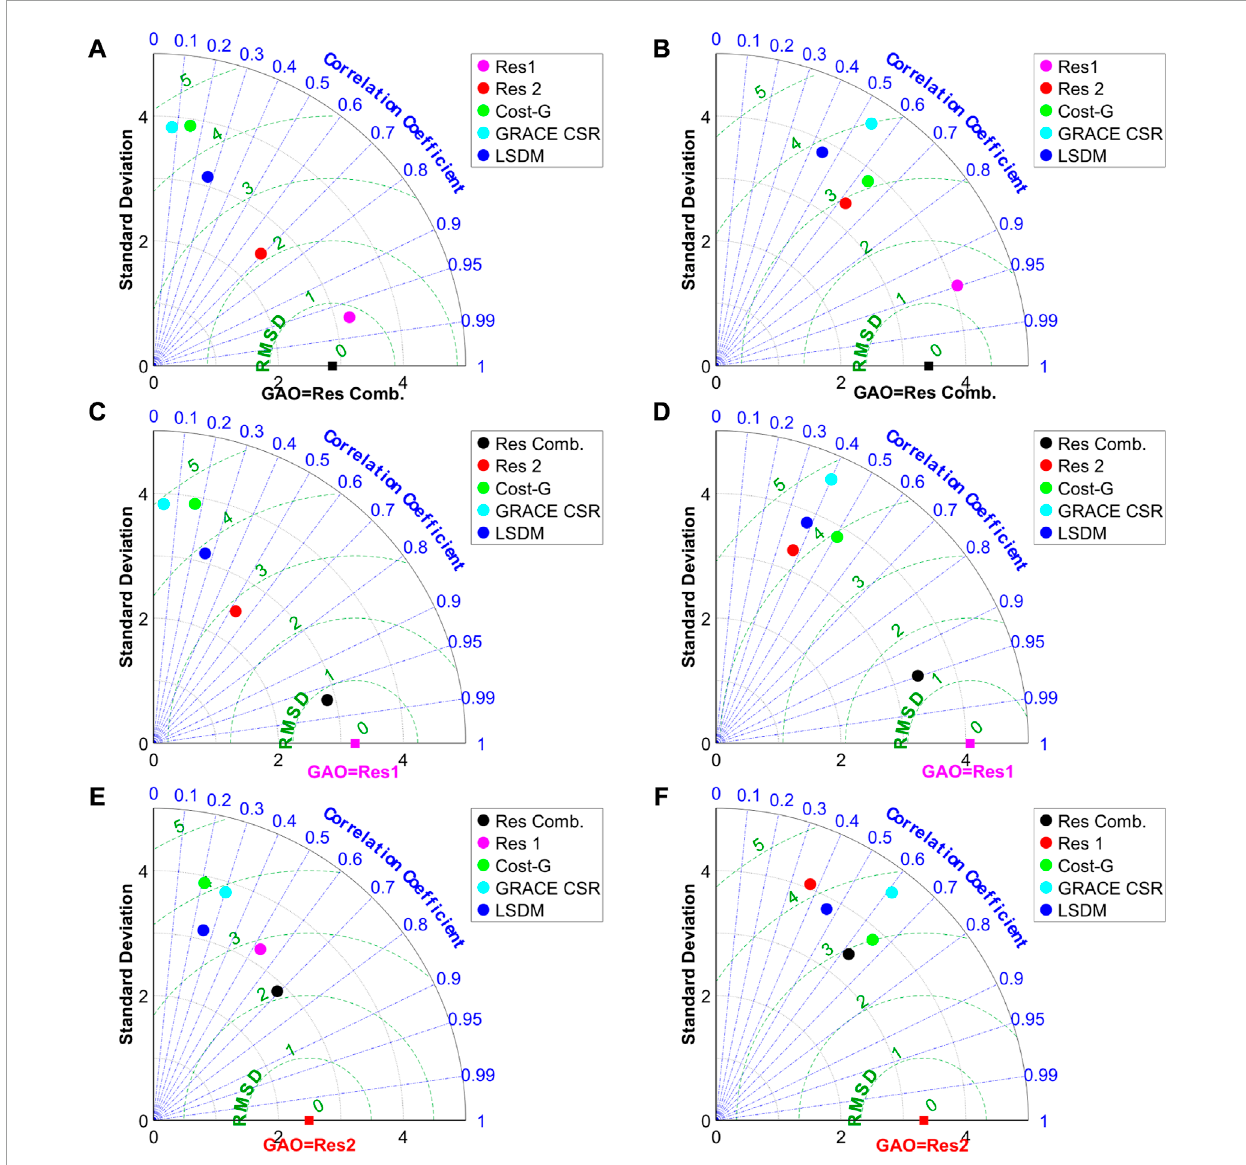
FIGURE 10 Taylor diagrams showing a comparison of χ 1 and χ 2 non-seasonal components of three different geodetic residuals as a reference vlaues: (A) χ 1 of Res Comb. (B) χ 2 of Res Comb., (C) χ 1 of Res1, (D) χ 2 of Res1, (E) χ 1 of Res2, (F) χ 2 of Res2, with gravimetric-based excitation determined from a single GRACE/GRACE-FO solution (CSR), combined GRACE/GRACE-FO solution (COST-G), and HAM LSDM hydrological